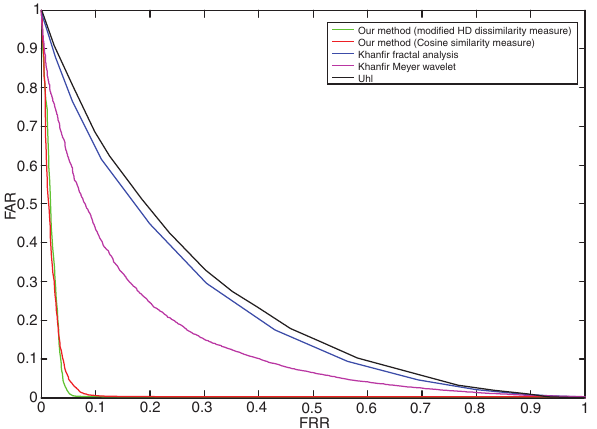
Figure 23. DET Curves on the CASIAV3 Image Database. The proposed method [using the modified HD dissimilarity measure and cosine similarity measure (red and green curves)] outperforms the state of the